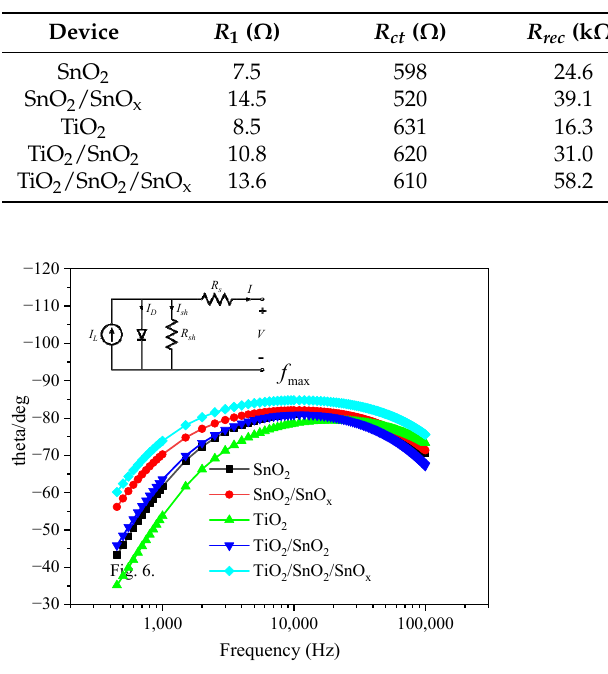
Figure 5. Nyquist plots of PSCs fabricated with the different conditions of ETL at: ( a ) light condition and ( b ) dark condition. Table 3. Electrochemical parameters fabricated with the different conditions of ETL calculated from EIS analysis.